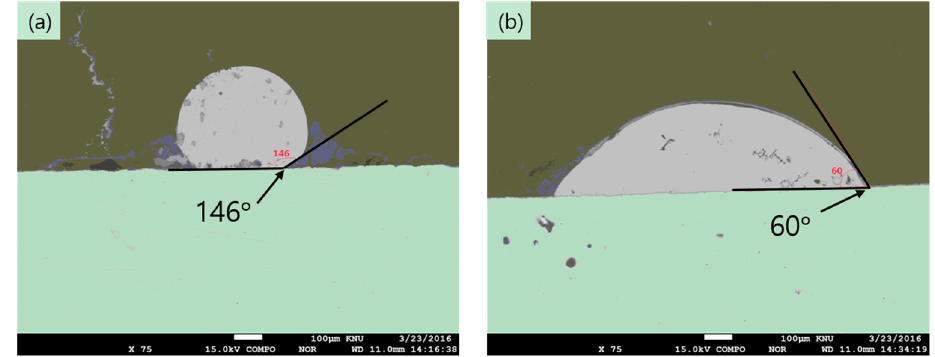
Figure 6. Effect of electroless Ni–P plating on solder spreadability of thermoelectric elements. ( a ) without and ( b ) with electroless Ni–P plating.